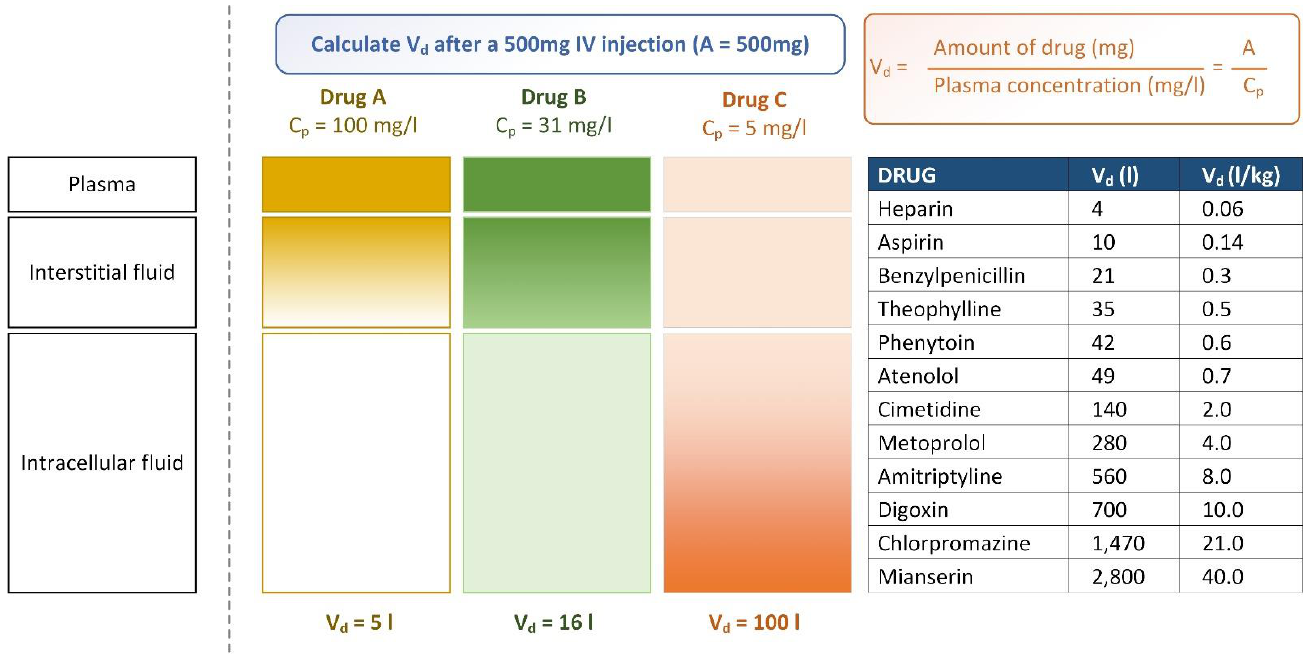
Figure 5. Examples of volume of distribution. Adapted from Maxwell [85].